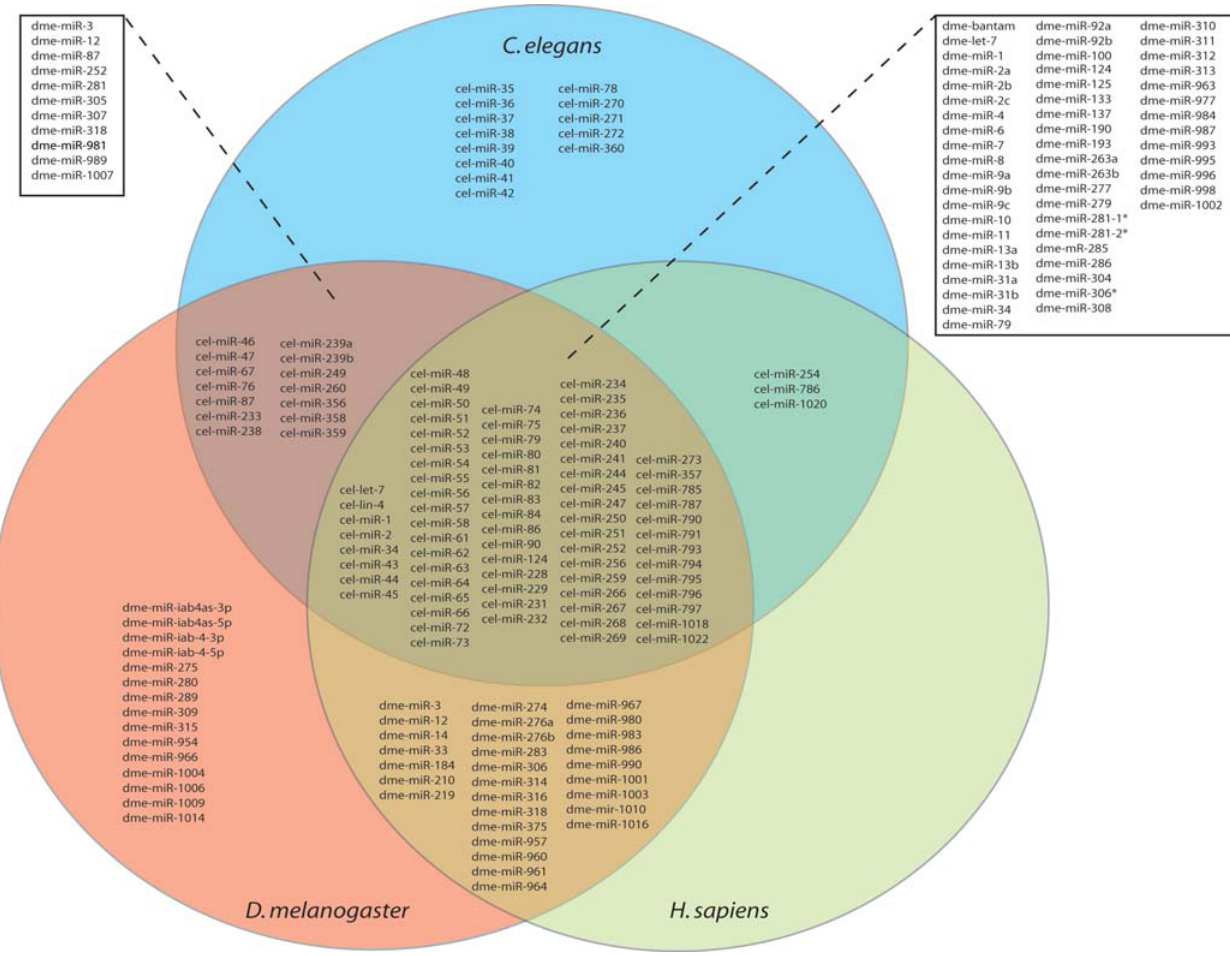
Figure 2. miRNAs of nematode and fly model organisms conserved across species (5 9 and/or overall $ 70%). 73/139 C. elegans miRNAs share 5 9 end identities and/or $ 70% homology over sequence with miRNAs both in fly and humans. 13 C. elegans miRNAs currently appear to have sequence-related miRNAs limited to C. elegans , 14 miRNAs are shared by nematodes and flies, and 3 miRNAs are shared by nematodes and humans. For Drosophila , 54/152 miRNAs have 5 9 and/or $ 70% overall homology to nematode and human miRNAs. 15 D. melanogaster miRNAs have sequence-related sequences restricted to fly, 11 miRNAs appear present both in fly and nematodes and 29 in fly and humans. Names of family members cross species can be found in Tables 1–6 and sequence alignments in supporting datasets and Figure S1. Human miRNAs that have family members only in human are not included. It should be noted that the Venn diagram is inclusive showing miRNAs that have 5 9 and $ 70% overall conserved sequences as well as miRNAs with either 5 9 or $ 70% overall conserved sequences. Thus, miRNA totals in the diagram sections do not necessarily match those stated in the main text referring only to 5 9 sequence identity or only to $ 70% overall homology. Moreover, dme-miR-3, dme- miR-12 and dme-miR-318 are listed in both fly_nematode and fly_human groups but not in the fly_nematode_human group because their corresponding C. elegans and H. sapiens homologs are not cross related in sequence under our criteria. Similarly, dme-miR-3, dme-miR-12, dme-miR- 263a and dme-miR-318 are included in both fly_nematode and fly_human groups but not in the fly_nematode_human group when only 5 9 homology is considered (main text).